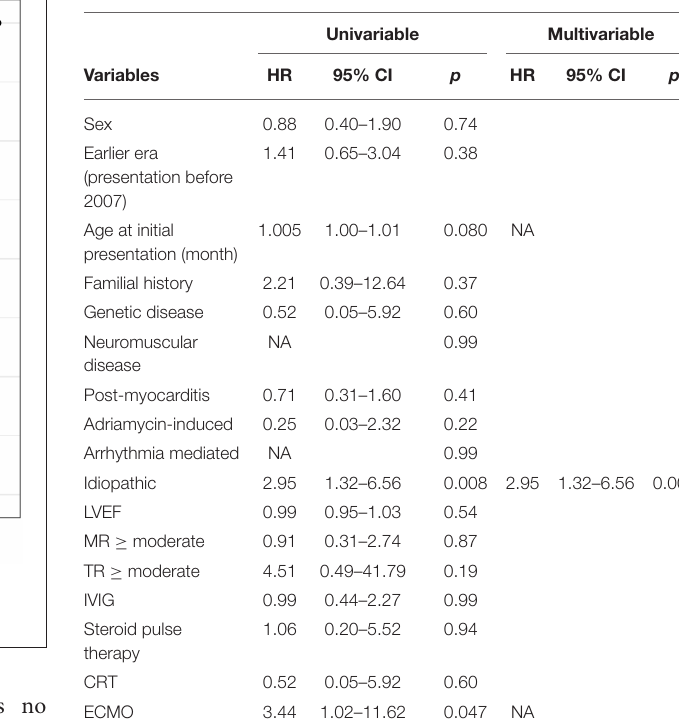
TABLE 4 | Risk factors for cardiac events within 2 years after initial